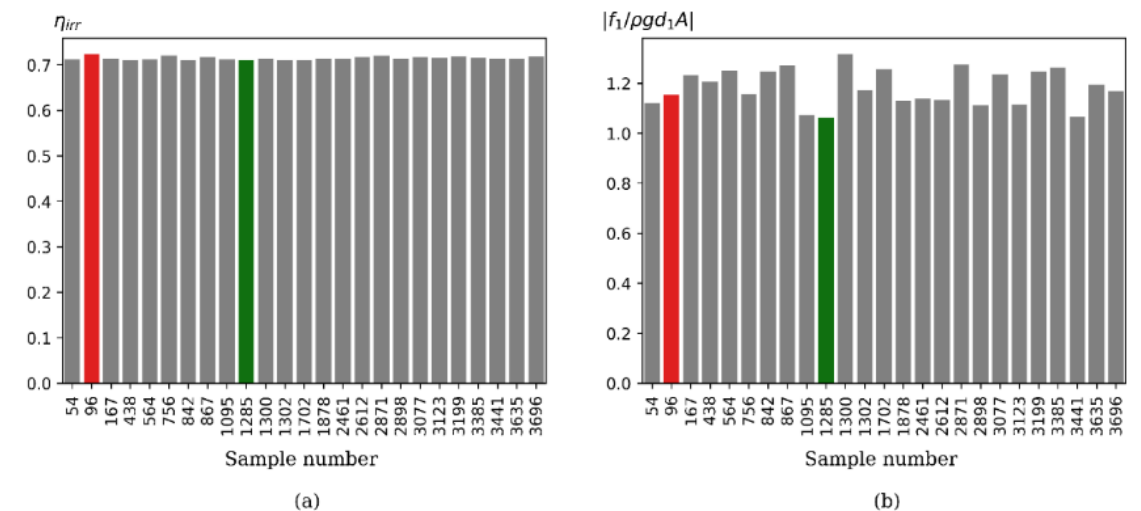
Figure 17. Predicted values of ( a ) conversion efficiency and ( b ) non-dimensional significant wave force on the barrier at T E = 5 s in irregular waves.